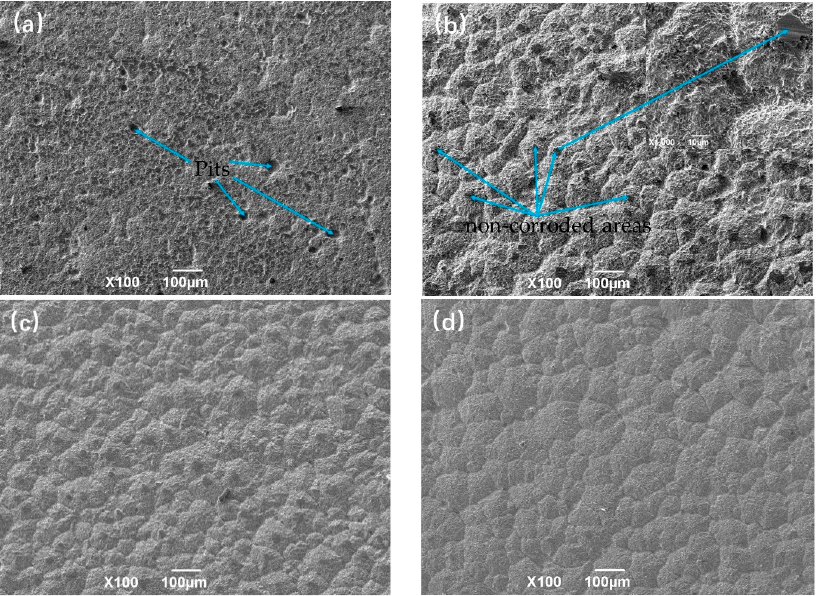
Figure 6. Corrosion morphology at 0 r/min ( a ), 60 r/min ( b ), 120 r/min ( c ), and 180 r/min ( d ), respec- tively.